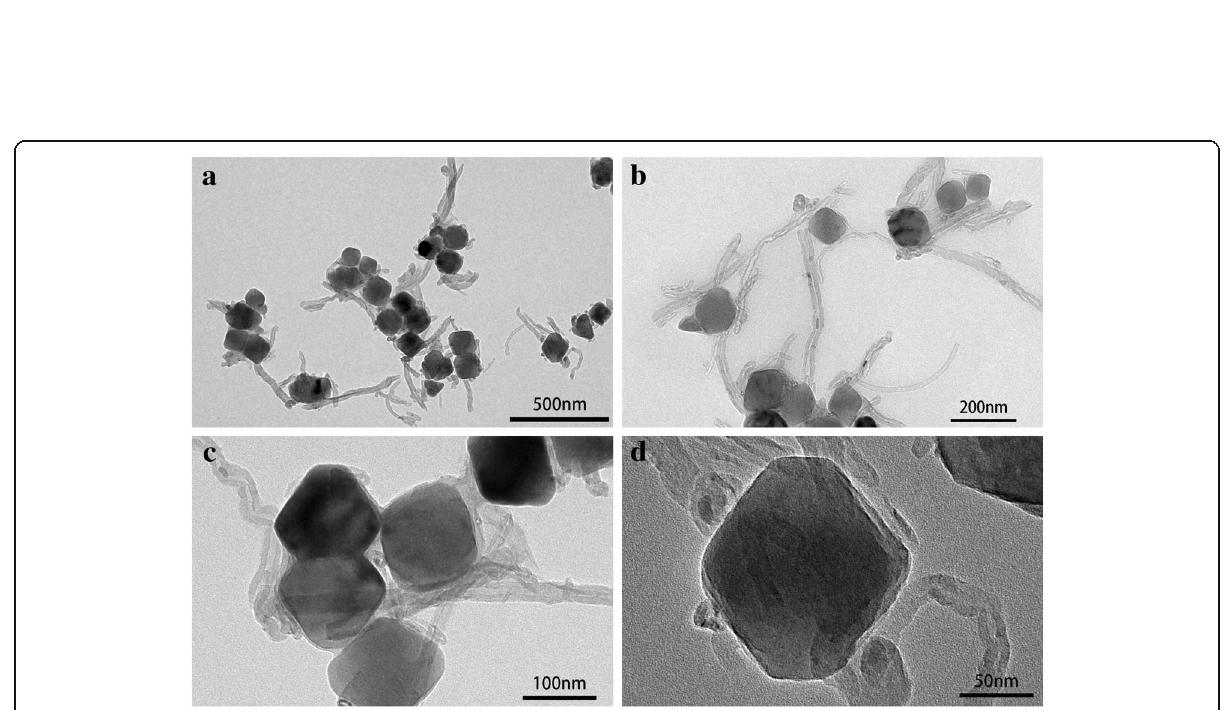
Fig. 4 a – d TEM images of K(Mn 0.95 Ni 0.05 )F 3 /MWCNT composites corresponding to different